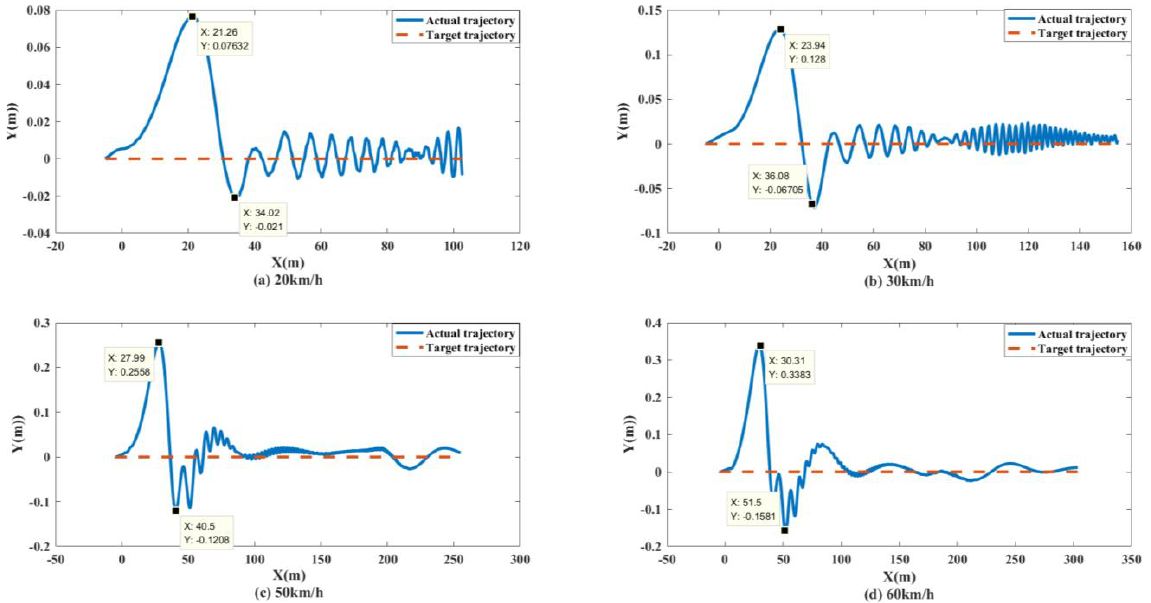
Figure 22. Path tracking curves of unmanned vehicles at different speeds on the Sine sweep straight road.